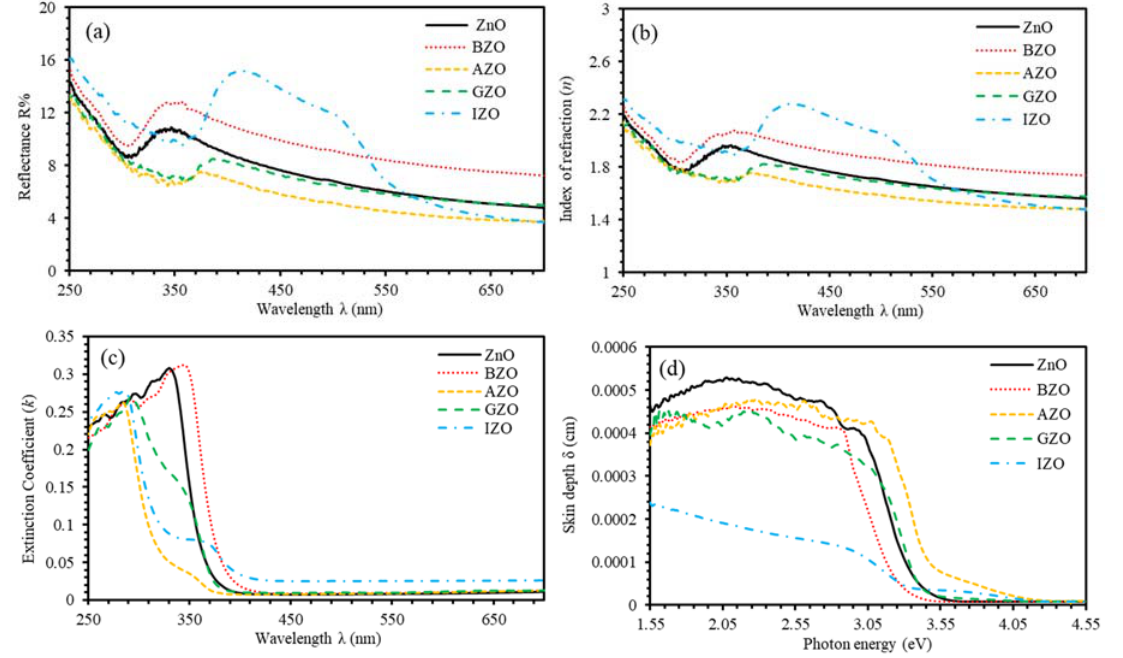
Figure 2. ( a ) Reflectance spectra, ( b ) index of refraction spectra ( n ), ( c ) extinction coefficient